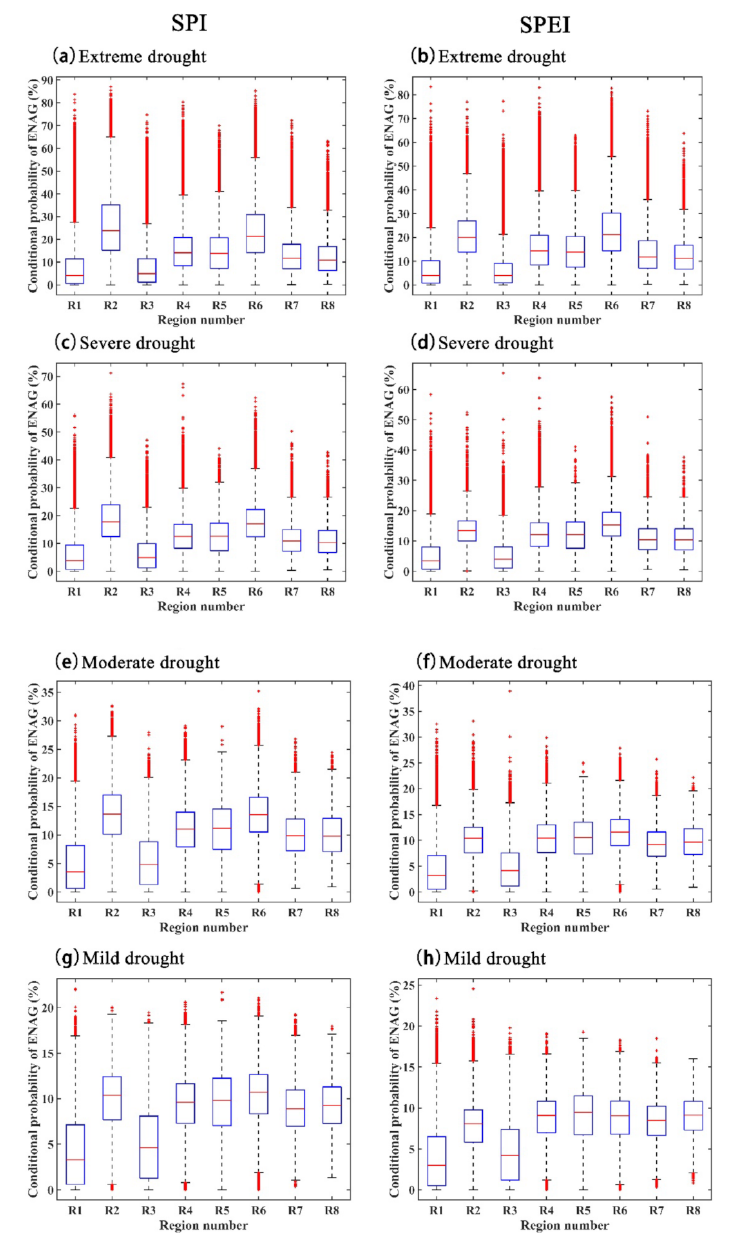
Figure 5. Boxplots of ENAG probabilities in each vegetation region under different drought levels. ( a , c , e , g ) represent extreme, severe, moderate, and mild drought classified in terms of the SPI, respec- tively; ( b , d , f , h ) represent extreme, severe, moderate, and mild drought classified in terms of the SPEI,